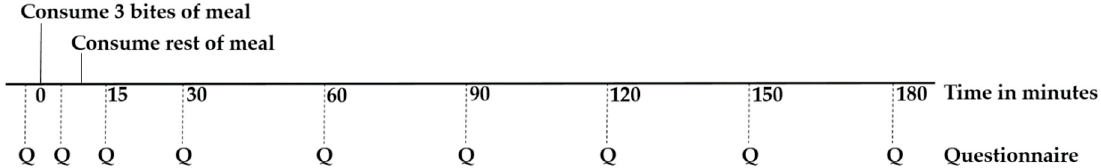
Figure 1. Schematic overview of the study with time intervals for answering of questionnaire.